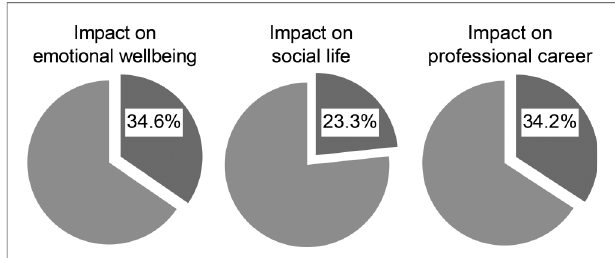
FIGURE 3 | Opinions of the general surgeons about patient losses.